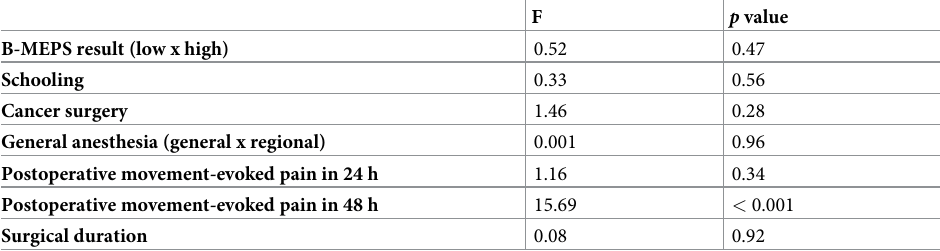
Table 8. Result for univariate analysis of variance for QoR-15 rehabilitation. B-MEPS result (low x high)